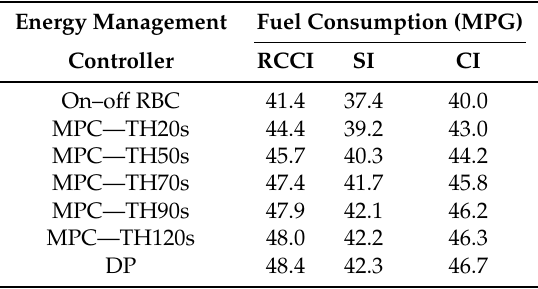
Table 5. Fuel economy comparison for different EMCs including the effect of MPC time horizon (TH) in the SHEV with SOC initial = 0.3 (EMC: 3-mode).